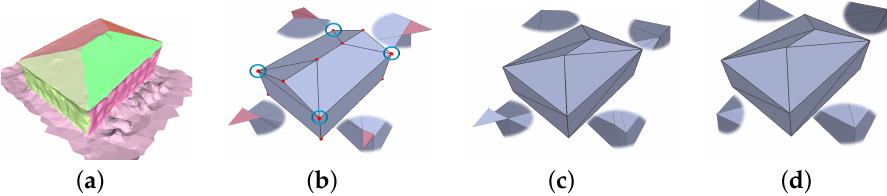
Figure 8. Optimization of corner point groups: ( a ) Segmentation, ( b ) Polyhedron, ( c ) SABMP [11], and ( d ) Ours.